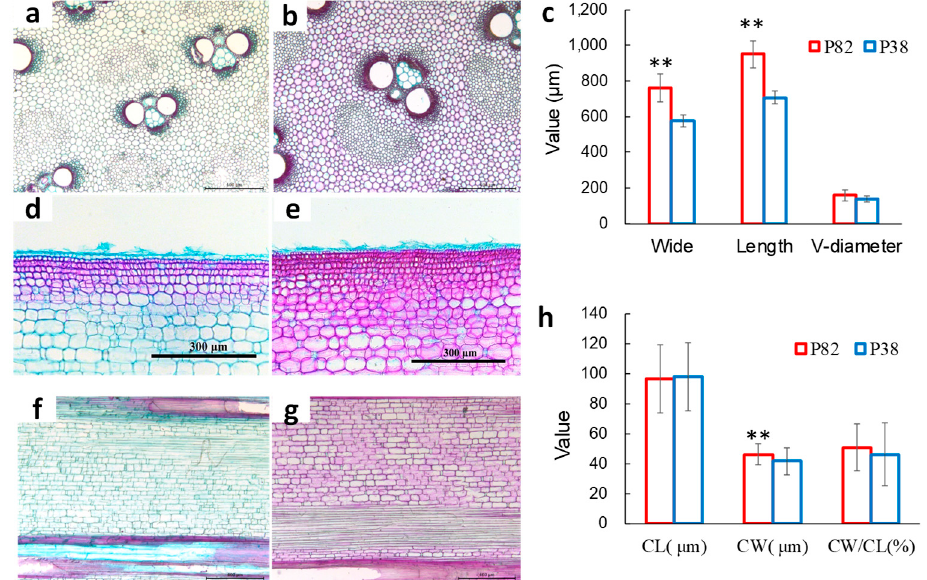
Figure 5. Cytological analysis of the culm of line P82 and line P38. ( a , b ) Cross-sections of the culm of line P38 and line P82, respectively; ( c ) comparative analysis of the vascular bundle size and diameter of the metaxylem vessel in line P82 and line P38; ( d , f ) longitudinal section of the culm in the outer layer and inner part of line P38; ( e , g ) longitudinal section of the culm in the outer layer and inner part of line P38. ( h ) Comparative analysis of the parenchyma cell size in line P82 and line P38. CL, cell length; CW, cell wide; CW/CL (%), cell wide/cell length (%). ** Indicate significant differences at p < 0.01